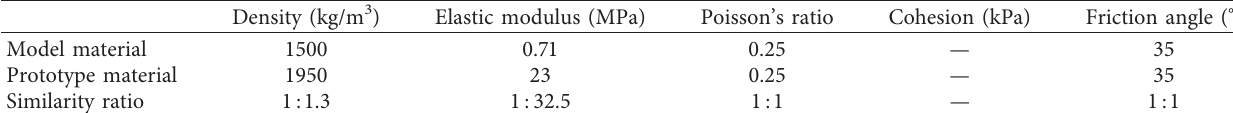
Table 5: Physical parameters of the faults.